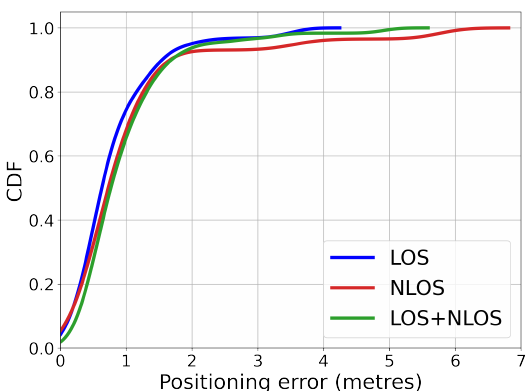
Figure 14. The CDF result of WiFi fingerprinting using the signal measures from only LOS APs, NLOS APs, and all the APs. Please note that all statistical features from the corresponding APs were leveraged. Introducing NLOS signal measures greatly reduced the performance accuracy. The largest positioning error was up to 7